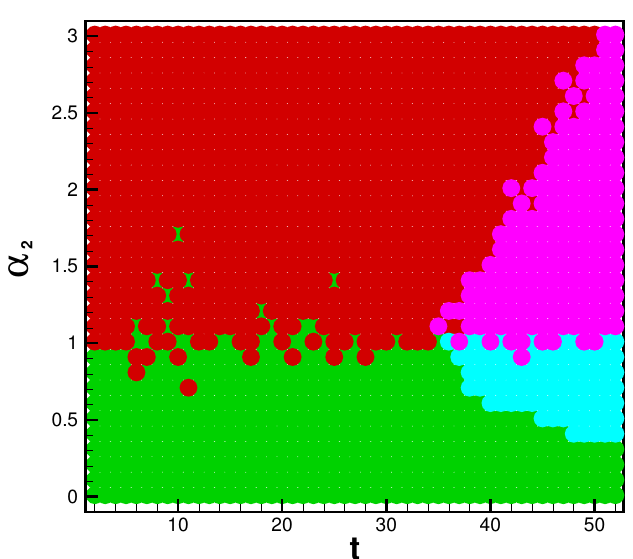
Figure 5. This contour shows the dominant pathway in our emergent strain model based upon seasonal data for the flu season beginning 2015 and varying control parameter α 2 . The colors green, cyan, red, and purple refer to the pathways A , BA , AB , and B respectively, as defined in Figure 1d.